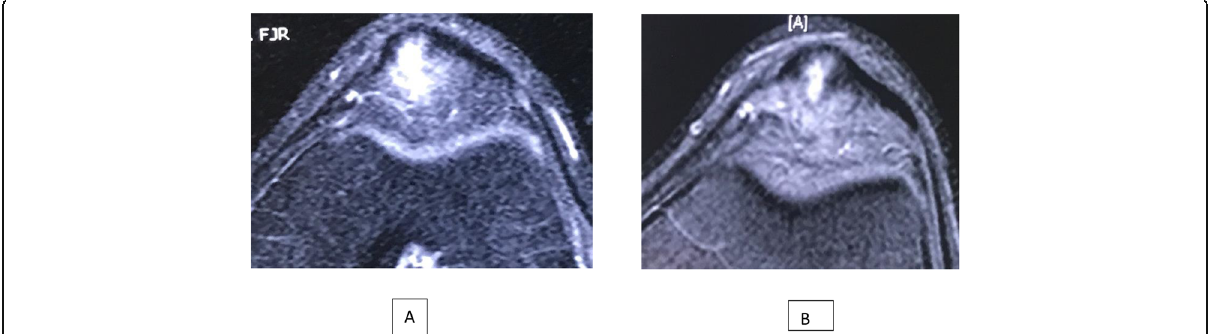
Fig. 6 A : Axial STIR MR image of the tear of the patellar tendon pre-injections or baseline. B : MRI axial view of the patellar tendon at 6 months